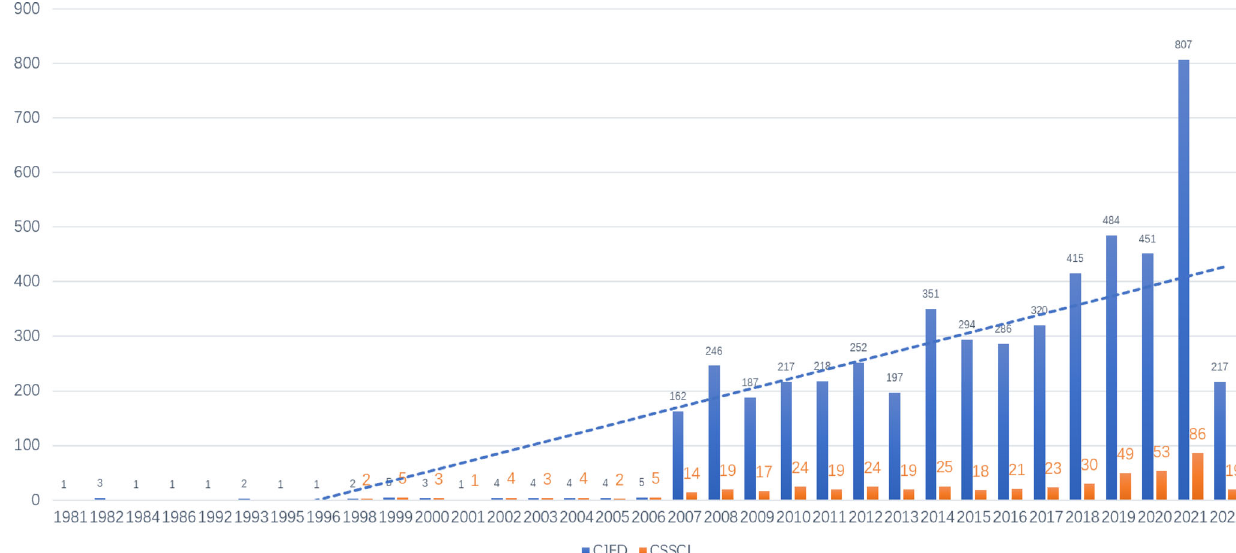
Fig. 7 Comparison of the annual quantity of Chinese grand canal literatures in CJFD and CSSCI databases (1981 –